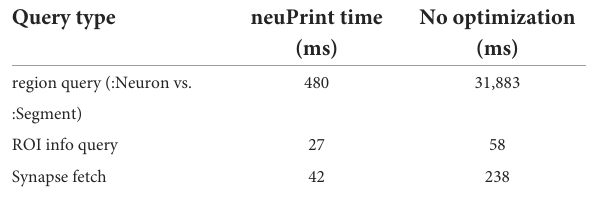
TABLE 3 Optimized vs. non-optimized query performance. TABLE 4 Performance of example